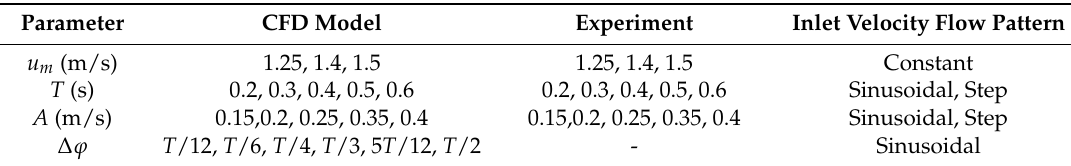
Table 2. Conditions of simulations/experiments.